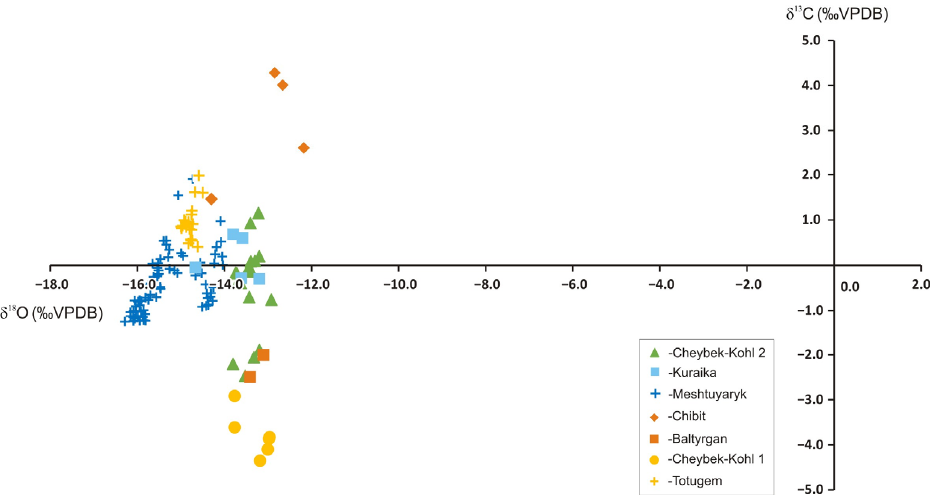
Figure 15. Stable isotope properties of the CaCO 3 from travertines of the south-eastern Gorny Altai (see Table S1).